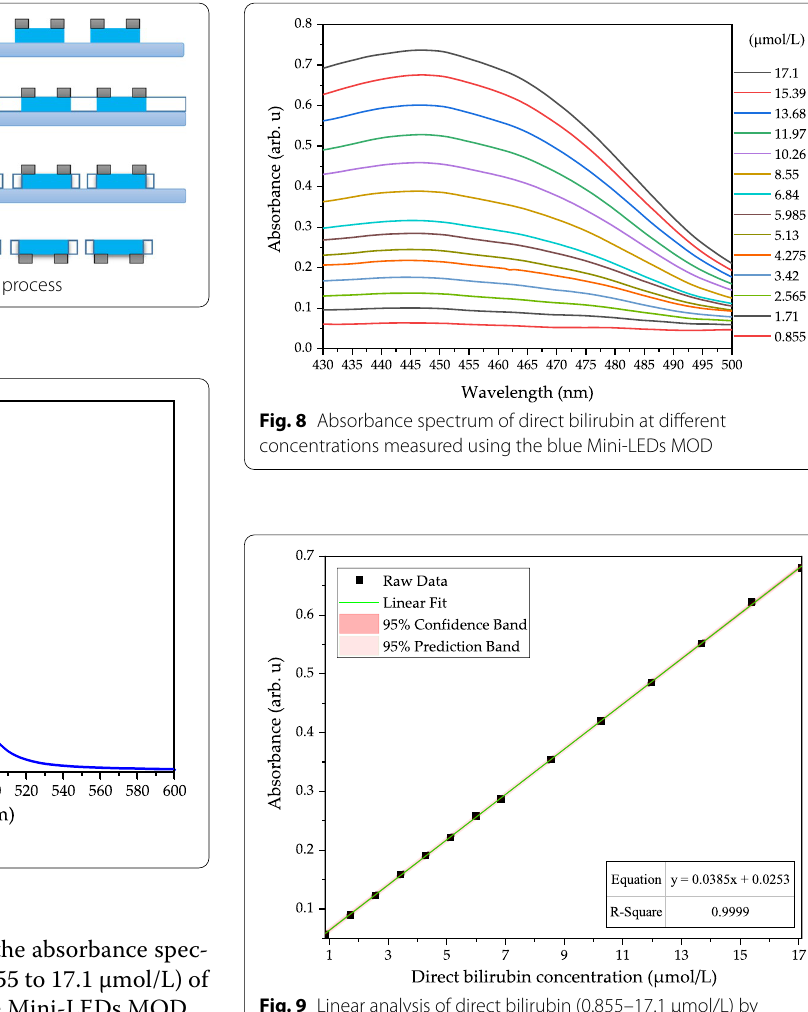
Fig. 9 Linear analysis of direct bilirubin (0.855–17.1 μmol/L) by blue Mini‑LEDs MOD at 462 nm; the regression equation was y 0.0385 x 0.0253, R . 2 of = +